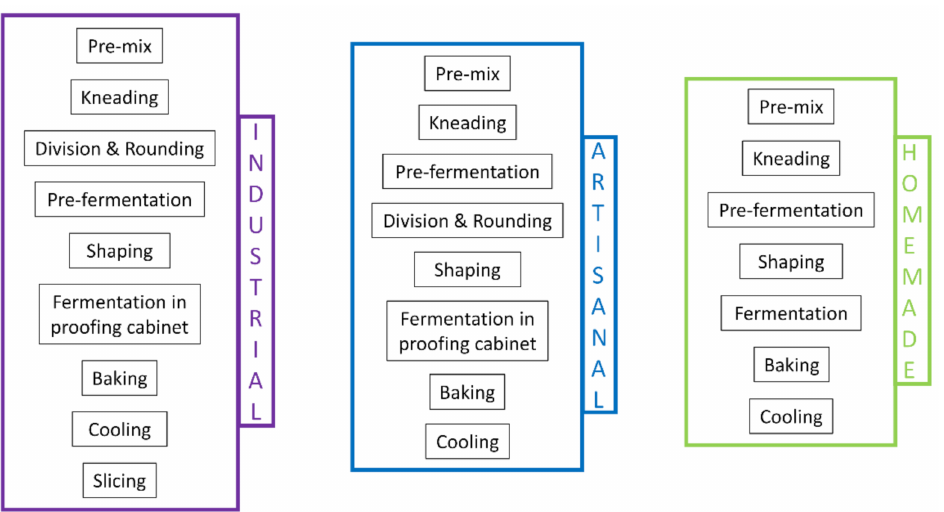
Figure 1. Examples of a production diagram for industrial, artisanal, and homemade soft breads, listing the general unit operations for